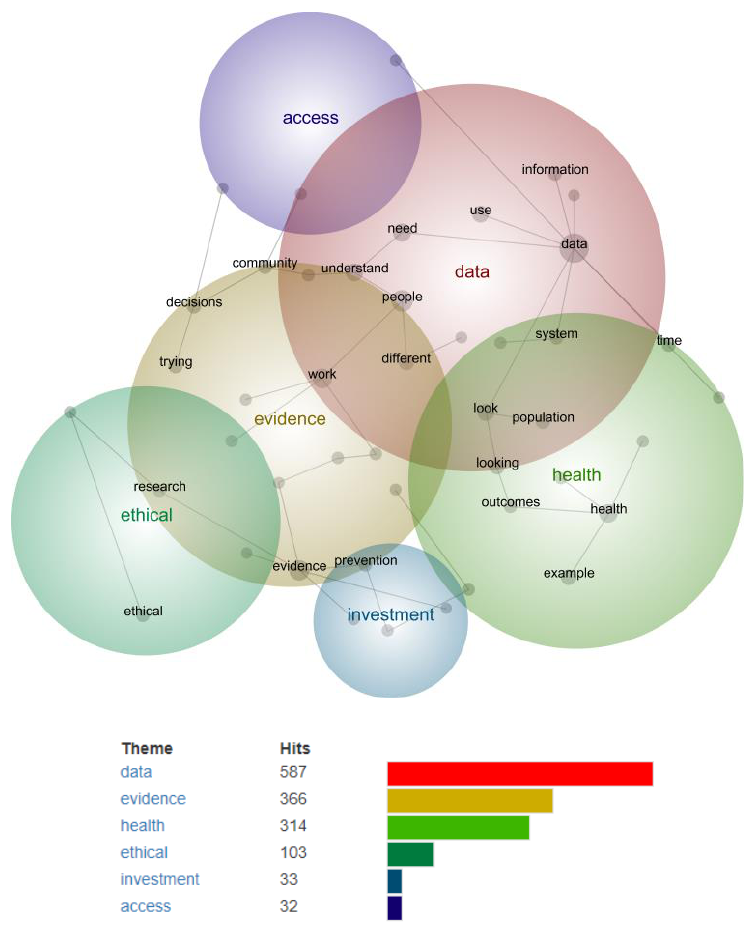
Figure 1. Concept map from Leximancer data analysis (stage one).